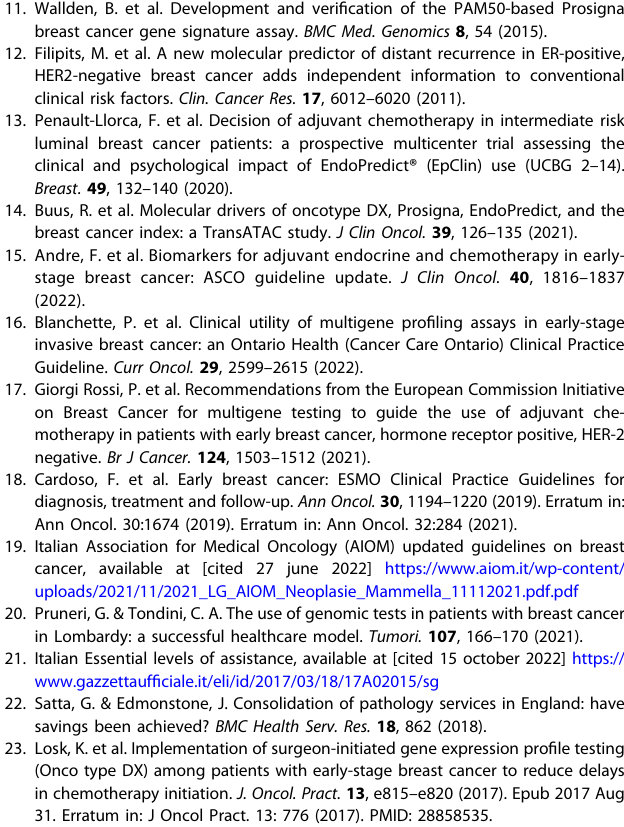
Fig. 1 Work fl ow and turn-around-time (TAT) of breast cancer patients multigene testing. a A scheme of the current management, underlining the potential role of re fl ex testing actioned by pathologist in shortening TAT. b Detail of the pathology lab workload and TAT for outsourced and in house multigene testing. Third party material not